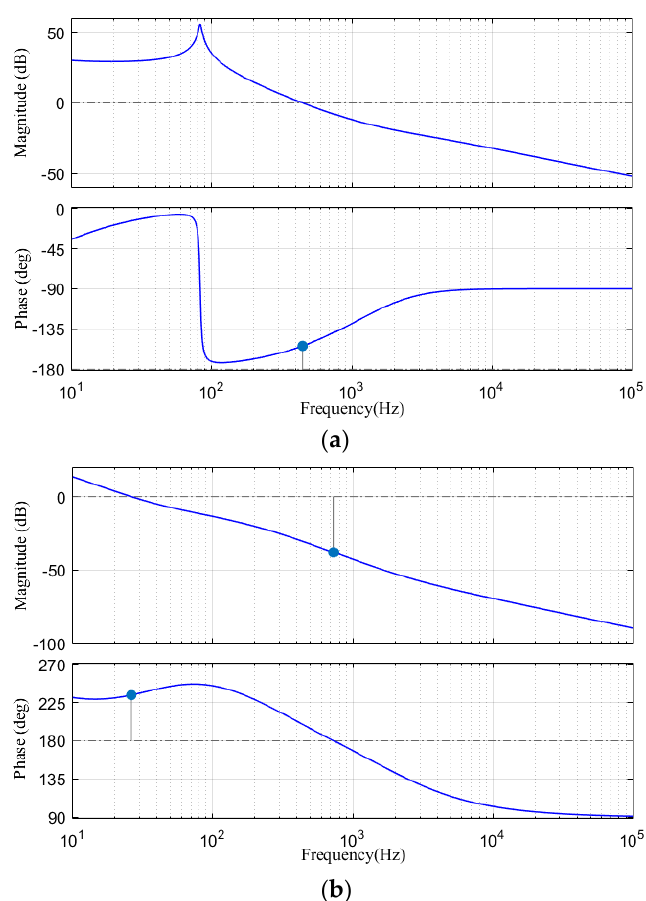
Figure 7. ( a ) Current loop open loop transfer function; and ( b ) open-loop bode diagram of systems with Controller.